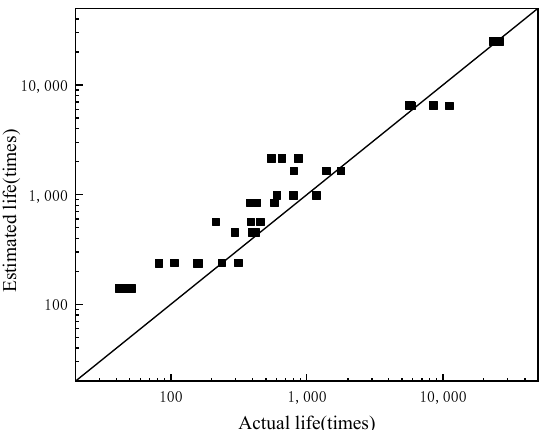
Figure 5. Comparison between estimated fatigue life and actual fatigue life.